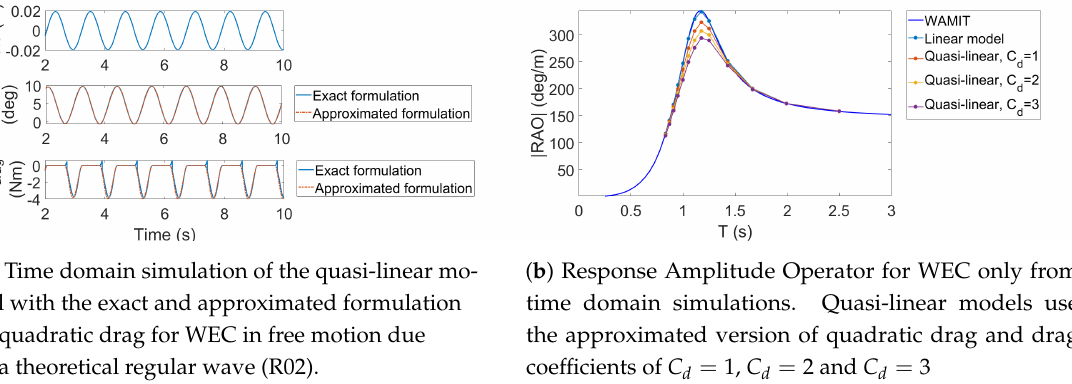
Figure 14. Comparison between exact and approximated formulation of quadratic drag forces in time domain ( a ) and representation of the effect of the quadratic drag coefficient in the pitch motion in frequency domain calculated from time domain simulations ( b